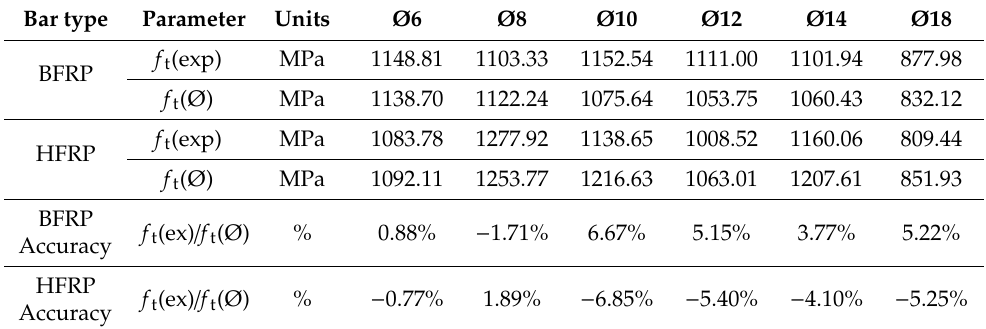
Table 9. Comparison between the tensile strength values of experimental and calculated